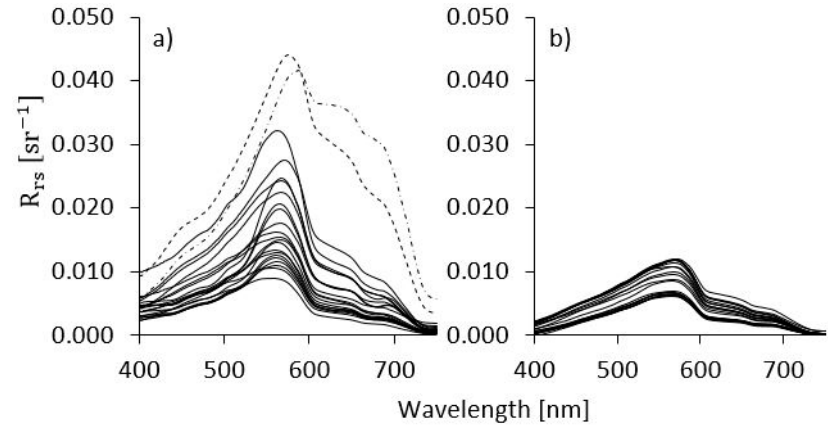
Figure 4. Field R rs ( λ ) values for: ( a ) 2013; and, ( b ) 2019. Figure 4. Field 𝑅 (cid:3045)(cid:3046) (λ) values for: ( a ) 2013; and, ( b ) 2019. Figure 4. Field 𝑅 (cid:3045)(cid:3046) (λ) values for: ( a ) 2013; and, ( b ) 2019.